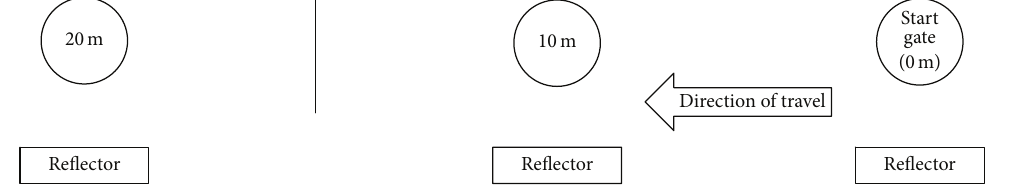
Figure 2: Positioning of the timing lights and iOS device.